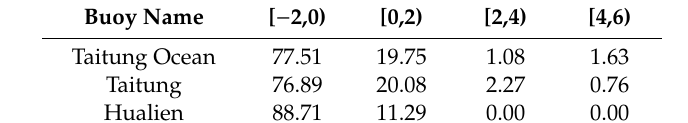
Table 5. Percentage of model-data di ff erence for di ff erent classes and buoys using winds from ERA5_1hr_H1.